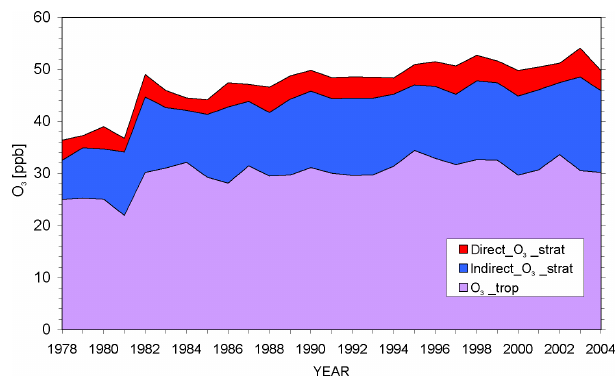
Figure 1. Annual mean ozone mixing ratios for the Zugspitze sum- mit from 1978 to 2003, together with preliminary estimates of the directly detected stratospheric component (red) and of the indi- rect component (blue) obtained from 7 Be measurements: the strato- spheric influence doubled during that period. As a consequence af- ter 1981 the positive ozone trend disappears after subtracting the evaluated stratospheric fraction of ozone. The figure of H. E. Scheel is taken from the ATMOFAST final report (2005; Fig. 2.40 on p.